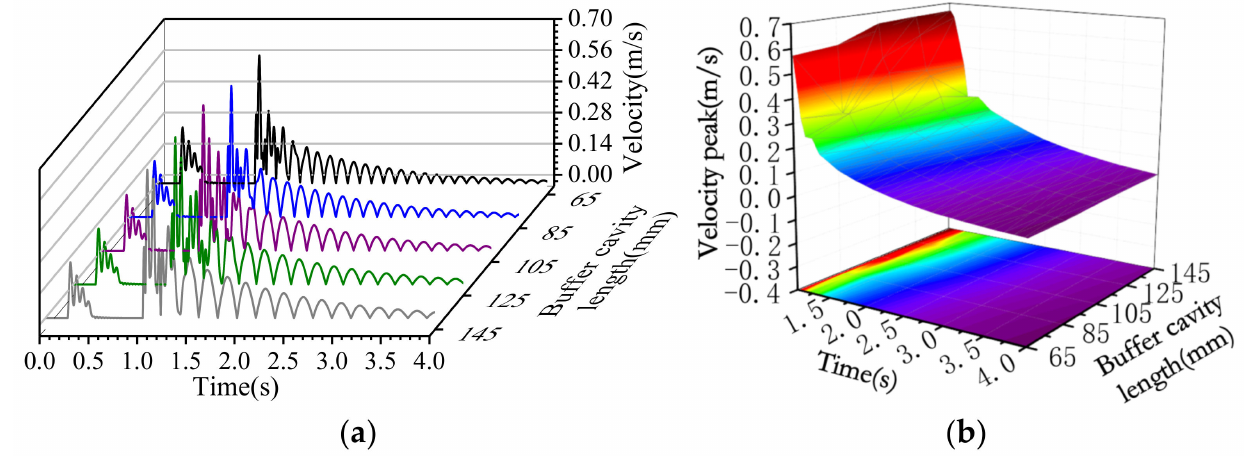
Figure 13. ( a ) Speed comparison of piston rod. ( b ) Peak fitting of velocity